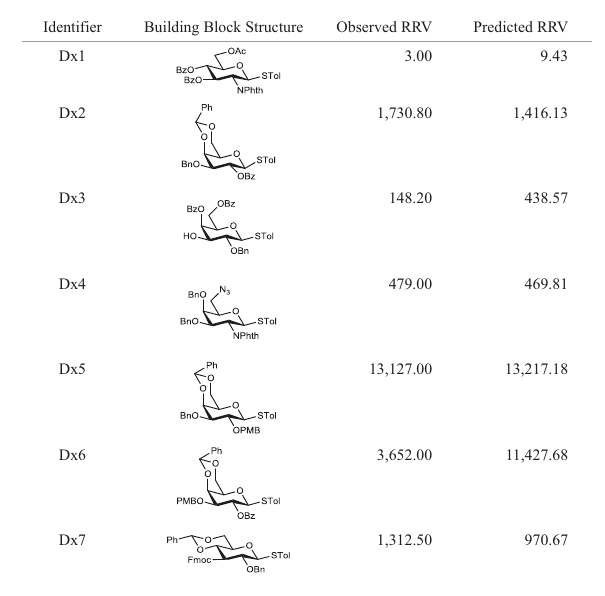
Table 2 Predicted and observed RRVs of representative virtual building